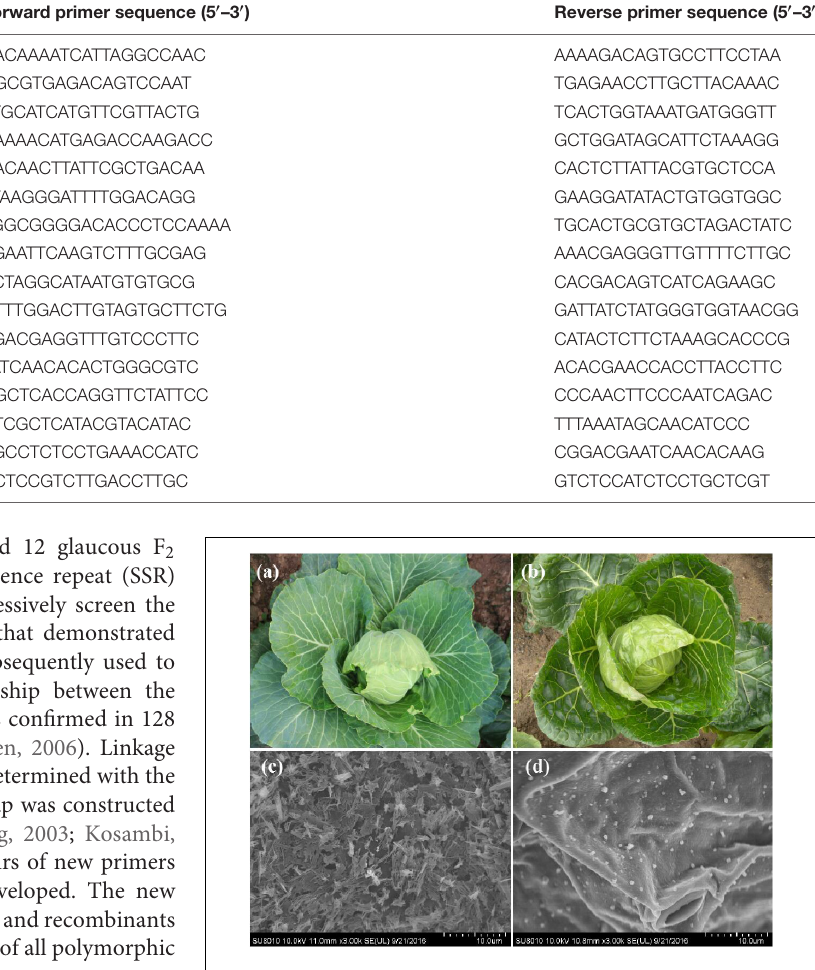
FIGURE 1 | T Phenotypic characteristics of WT and HUAYOU2. (a) Appearance of leaf in WT; (b) appearance of leaf in HUAYOU2. (c) SEM showing wax crystals on the surface of leaves in WT; (d) wax crystals on the surface of leaves in